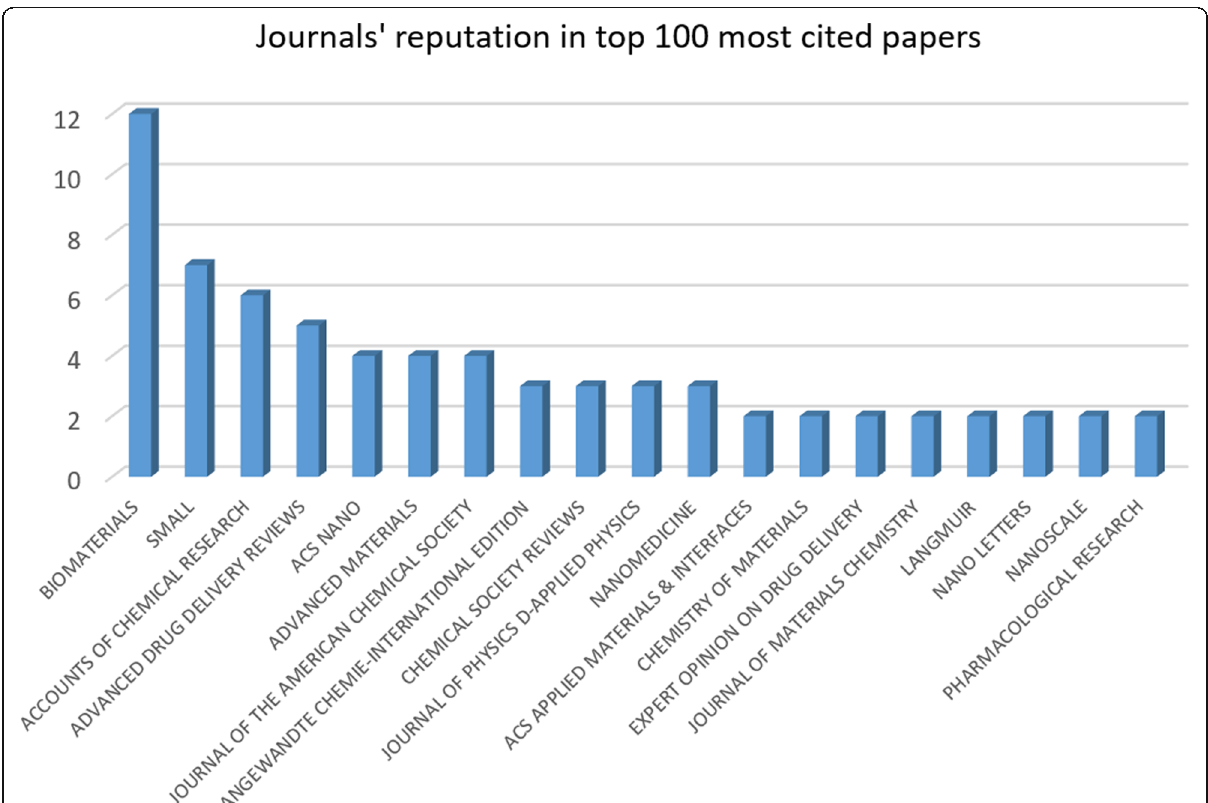
Fig. 9 Journals sorted by the number of papers published (journals are used least two